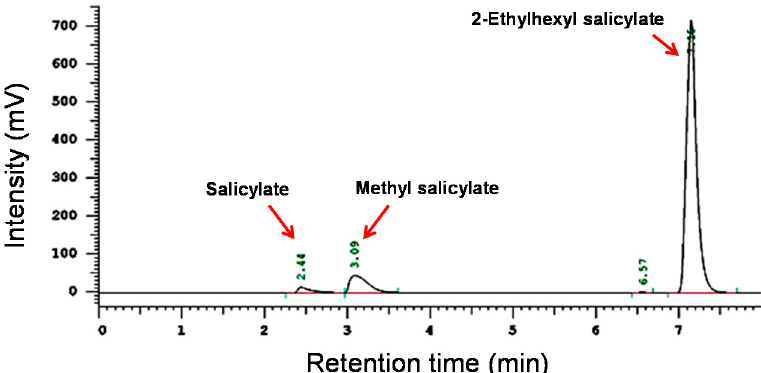
Figure 7. High-performance liquid chromatography (HPLC) chromatogram of 2-ethylhexyl Figure 7. High ‐ performance liquid chromatography (HPLC) chromatogram of 2 ‐ ethylhexyl salicylate.